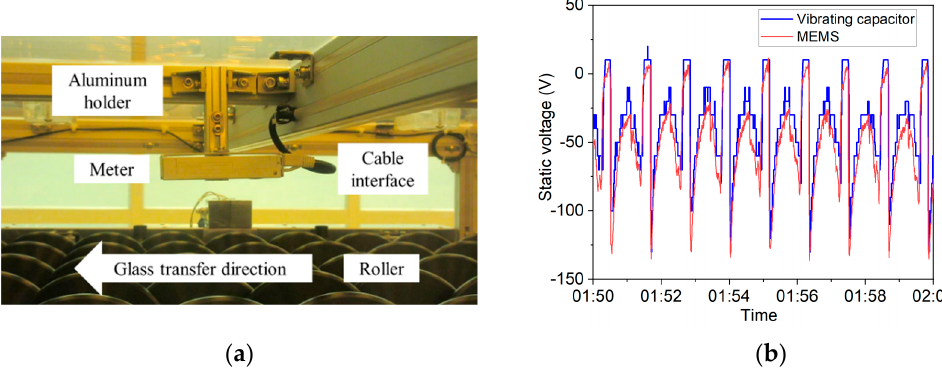
Figure 6. Real test installation and results. ( a ) Picture of the probe installed in the OLED product line. The glass moved beneath the meter by the roller, and the measure distance was 5 cm. The aluminum holder and the meter were both electrically grounded together. One single net cable was used to give power supply and transmit the measured data to the serial server. ( b ) Ten minutes data compared with the vibratory capacitor meter in the OLED manufacturing process. The vibratory capacitor meter was installed next to our meter in the same gap distance to the glasses.